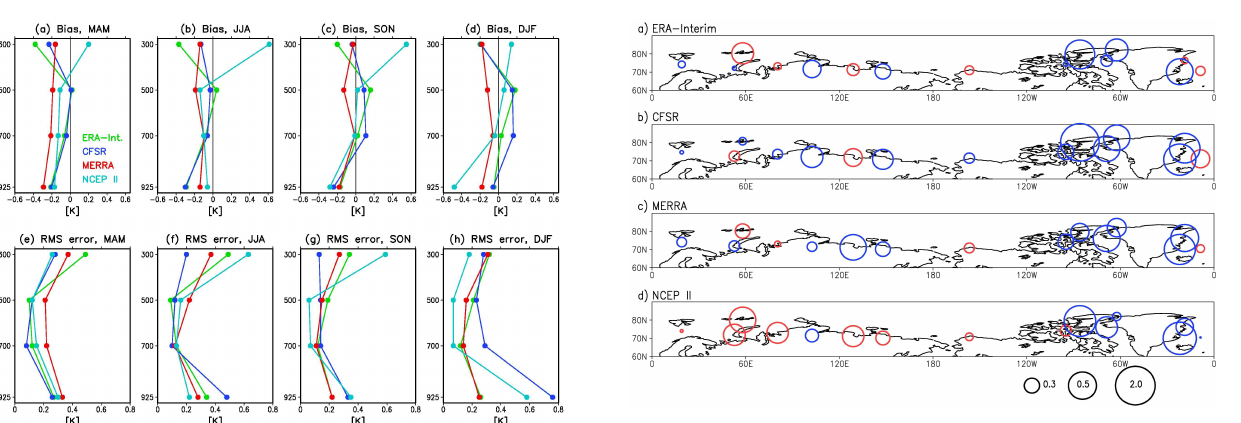
Fig. 7. Mean bias and rms error of seasonal 70–90 ◦ N average tem- perature in each reanalysis, relative to the IGRA data, in units of K. In the computation, we use the reanalysis data that correspond to the available IGRA observations.